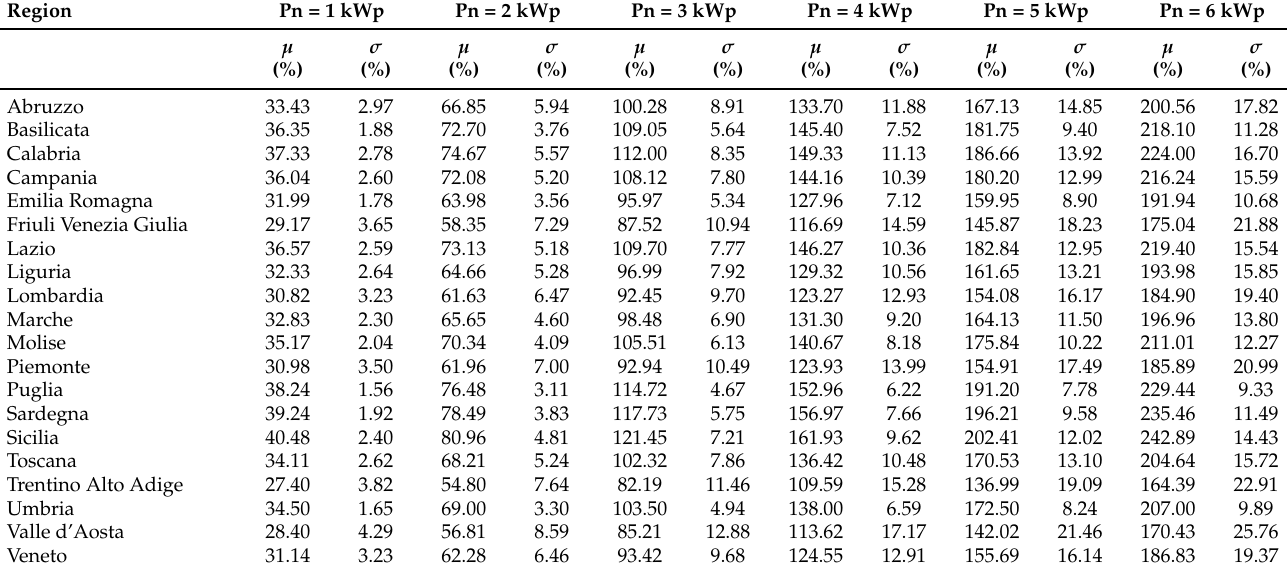
Table 20. CO 2 saving for E L = 4000 kWh without